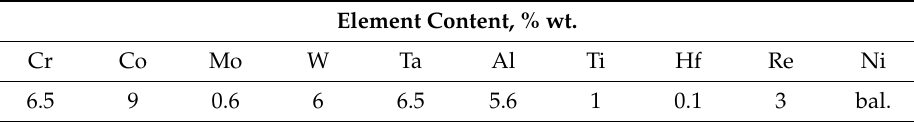
Table 1. The chemical composition of the CMSX-4 single crystal superalloy. Element Content, %